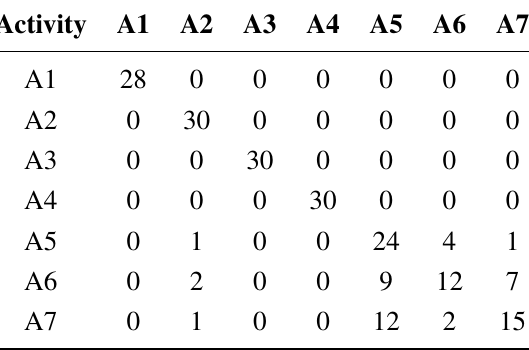
Table 6. Confusion matrix for Football Smartphone data for Experiment